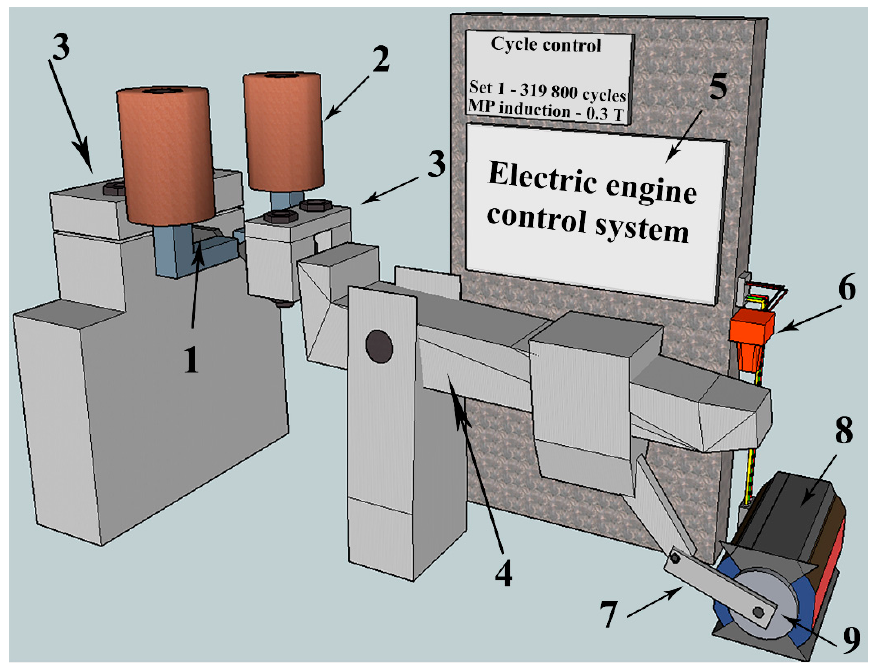
Figure 2. The unit used for the fatigue tests in a constant magnetic field. 1—sample, 2—electromagnet, 3—the unit for fixing the sample, 4—leverage mechanism, 5—control system, including the unit controlling the motor speed and the cycle counter, 6—photo censor, 7—eccentric, 8—motor, 9—axle.